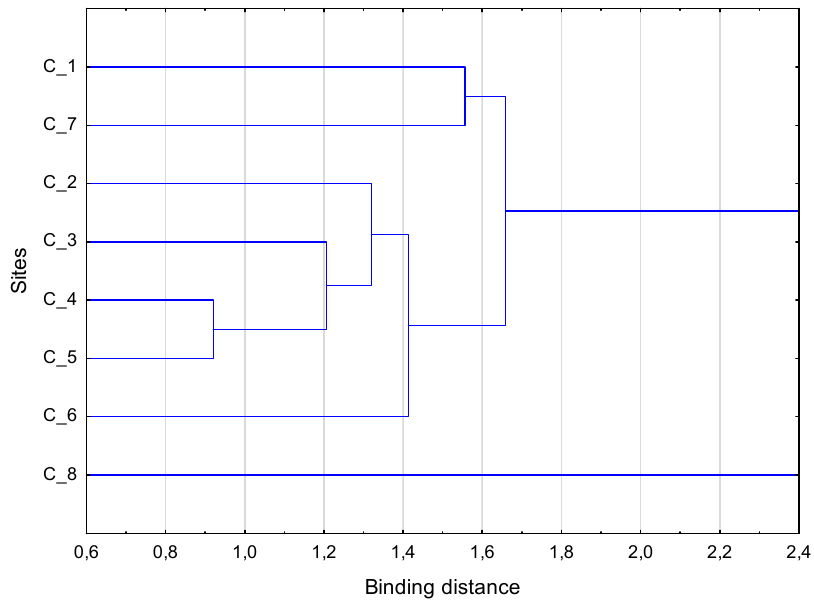
Figure 2. Cluster analysis of microarthropods from the forefield of the Midtre Lovén glacier close to Ny-Ålesund, Svalbard, based on Manhattan dissimilarities of double Wisconsin standardization abundances.